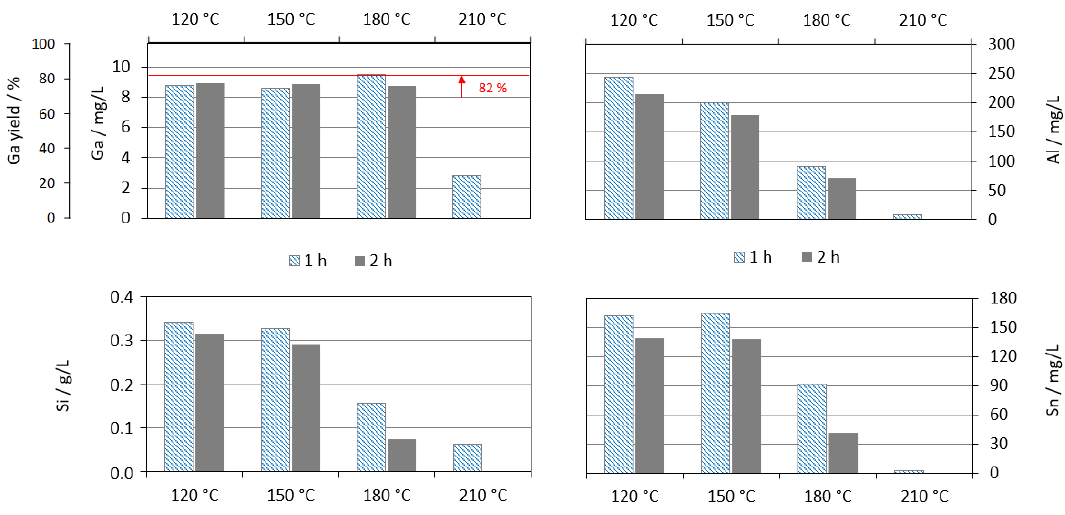
Figure 12. The elemental concentrations of gallium ( a ), aluminum ( b ), silicon ( c ), and tin ( d ) in the liquor after trial series B; the (maximum) gallium yield is indicated additionally; constants: 5 g / L NaOH, 5 bar O 2 , 800 rpm, S / L = 0.1.